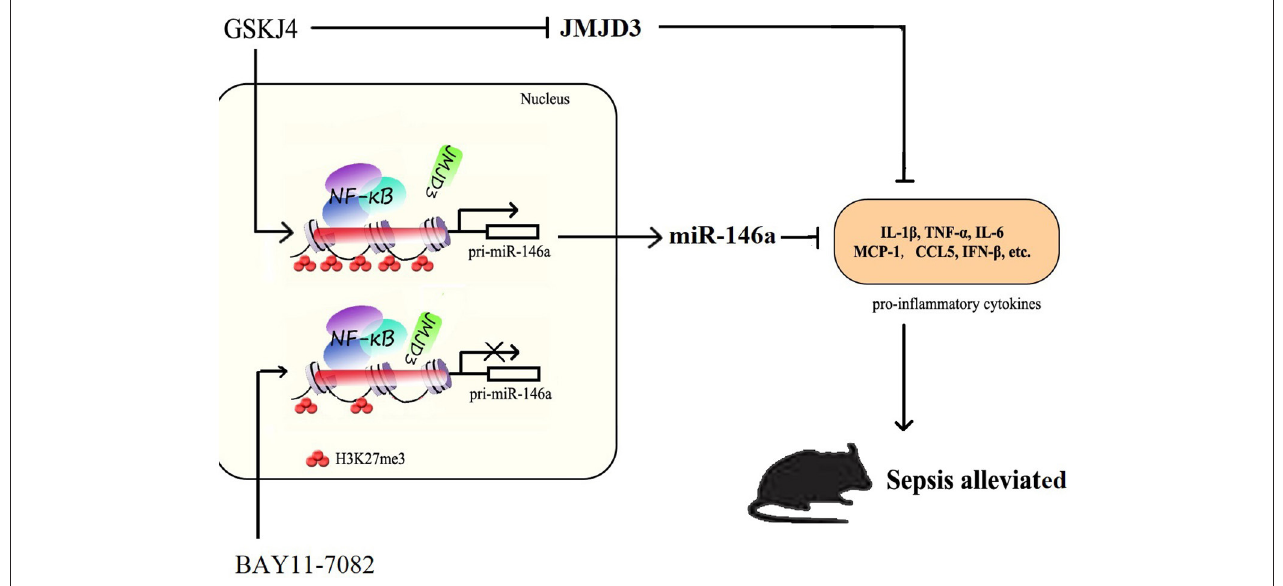
FIGURE 9 | JMJD3 specifically regulates miR-146a expression via its demethylation of H3K27me3. GSKJ4 treatment suppressed the binding of JMJD3 to the promoter region of pri-miR-146a, caused transcription of pri-miR-146a, and then induced the increase of miR-146a. GSKJ4 treatment decreased MCP-1, CCL-5 and IFN- β , that downstream to miR-146a, as well as IL-6, TNF- α and IL-23a, that downstream to JMJD3, ultimately lead to the protective effect against